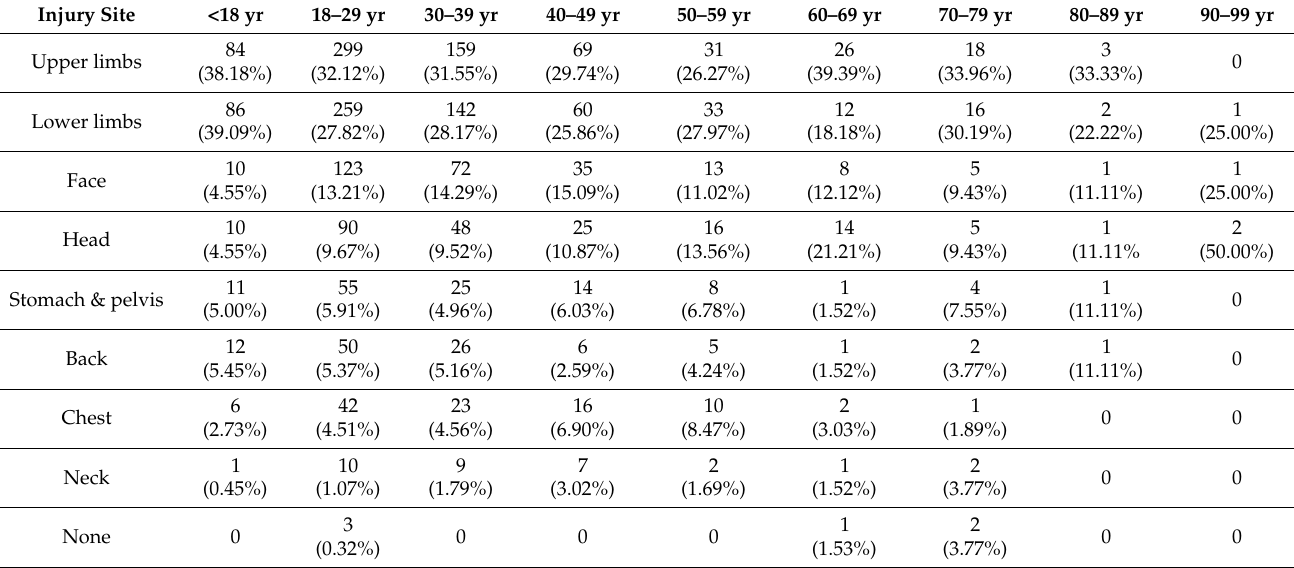
Table 3. Anatomic site of injury by age